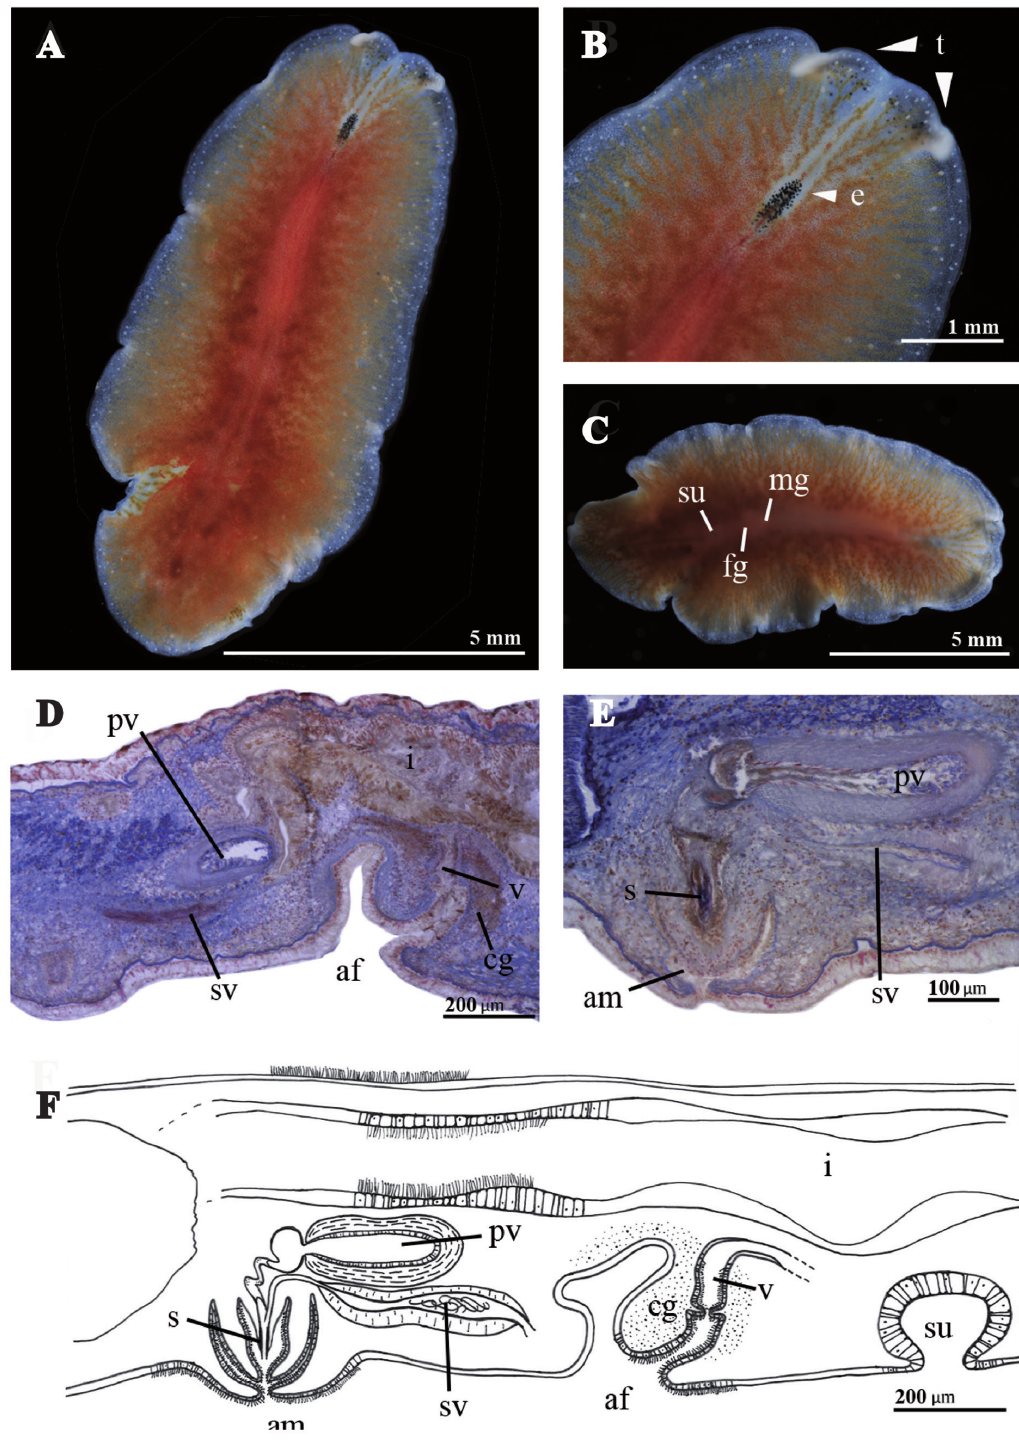
Fig. 6. Eurylepta cornuta var . melobesiarum (Schmidtlein, 1880) (RCCN). A . Whole live animal, dorsal view. B . Anterior region with eyes and tentacles (white arrows). C . Whole live animal, ventral view. D . Histological sagittal section of female copulatory organ. E . Histological sagittal section of male copulatory organ. F . Sagittal reconstruction of reproductive system. Abbreviations: see Material and